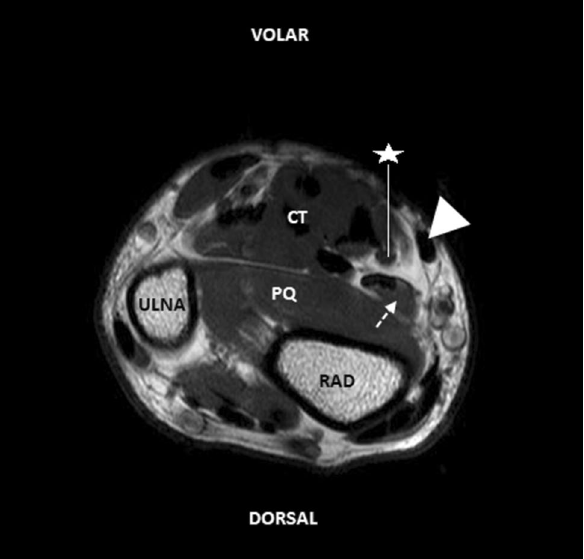
Figure 1. Axial T1W TSE MR image of the wrist; m. flexor carpi radialis tendon (arrowhead), m. flexor pollicis longus (dotted arrow), carpal tunnel contents (CT), m. pronator quadratus (PQ), radius (RAD), n. medianus